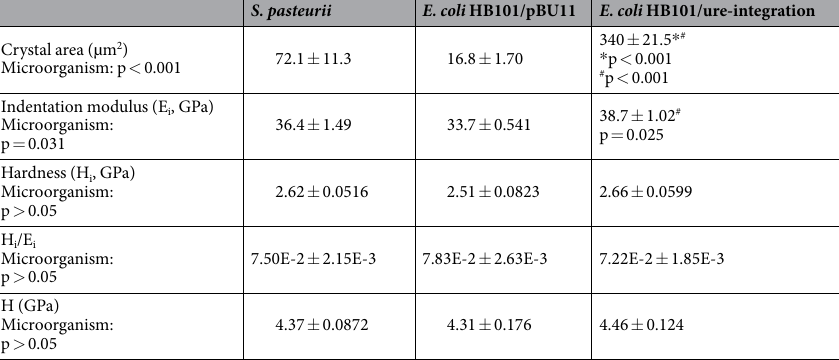
Table 1. Morphology and nanomechanical properties of biocalcite crystals. Data are presented as mean + / − standard error of the mean. One-way ANOVA result for the main effect of microorganism is reported in the left column. * Indicates significant difference compared with S. pasteurii ; # Indicates significant difference compared with E. coli HB101/pBU11. Post-hoc tests were adjusted for family-wise error with the Tukey procedure.